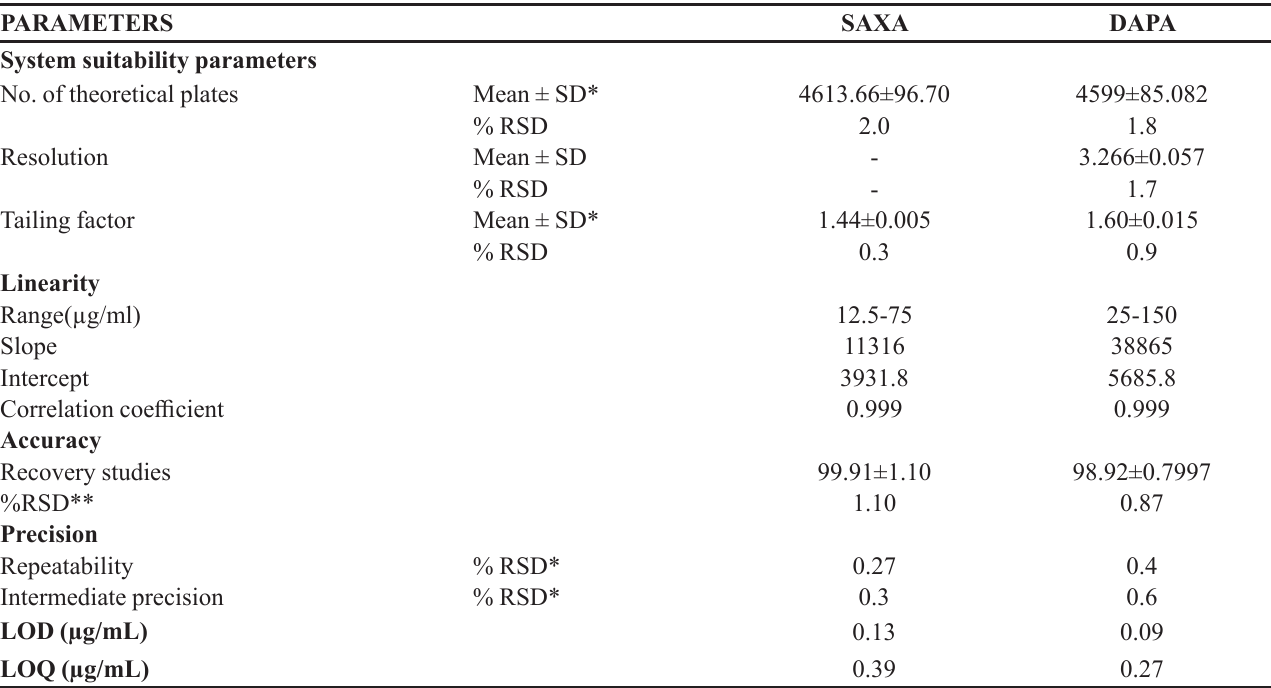
TABLE IV - Validation results for SAXA and DAPA